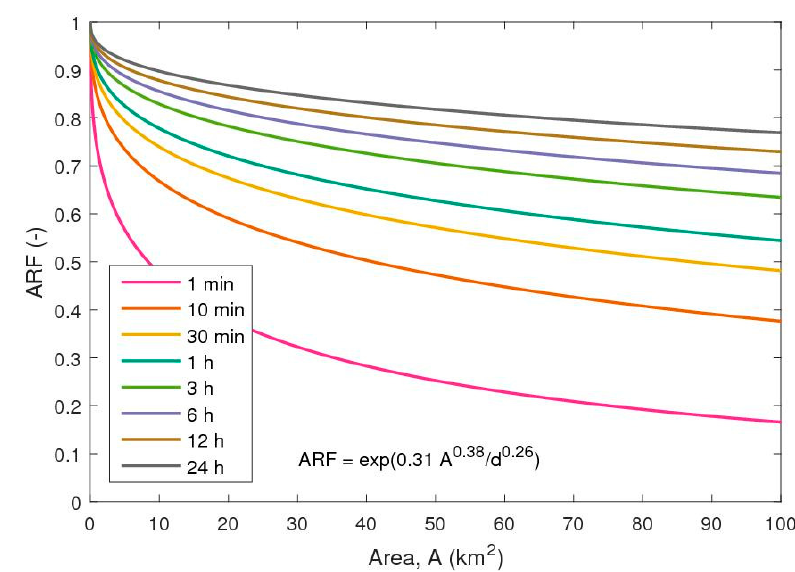
Figure 7. Mean aerial reduction factors as a function of area and duration. Figure 7. Mean areal reduction factors as a function of area and